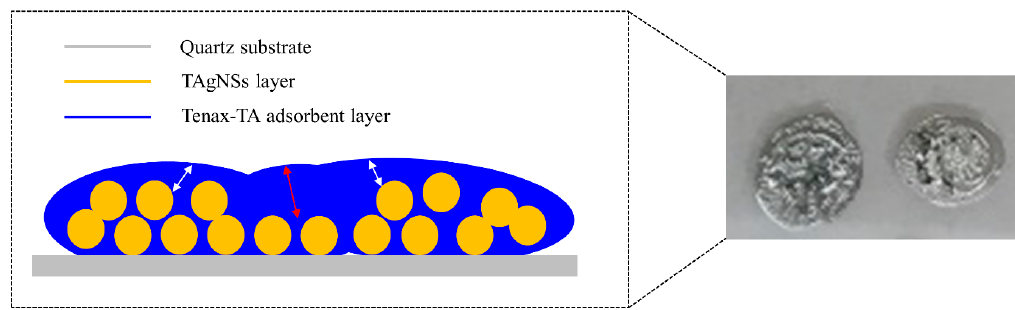
Figure 6. Scheme of transferred AgNSs-polymer complex-based SERS substrate.